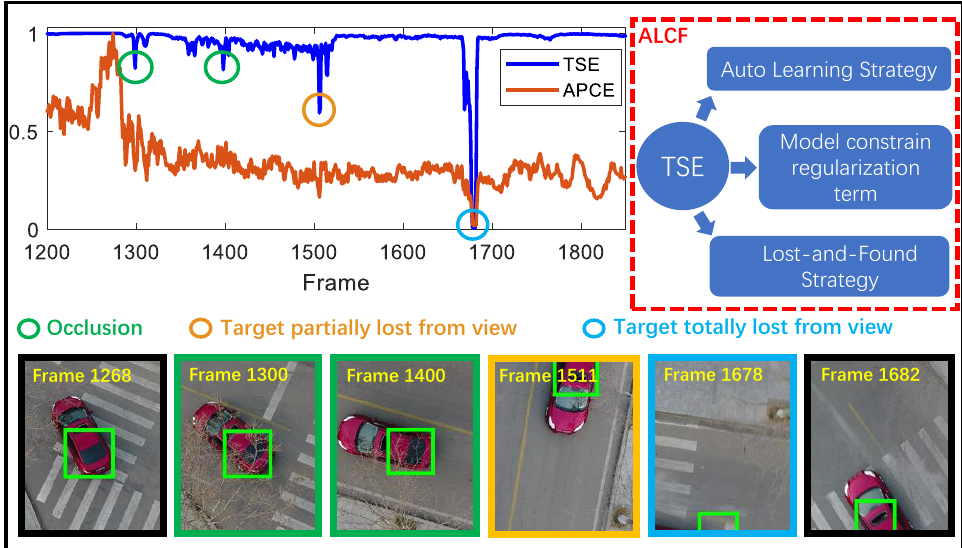
Figure 1. Comparison of the proposed TSE with APCE. The green box shows the tracking